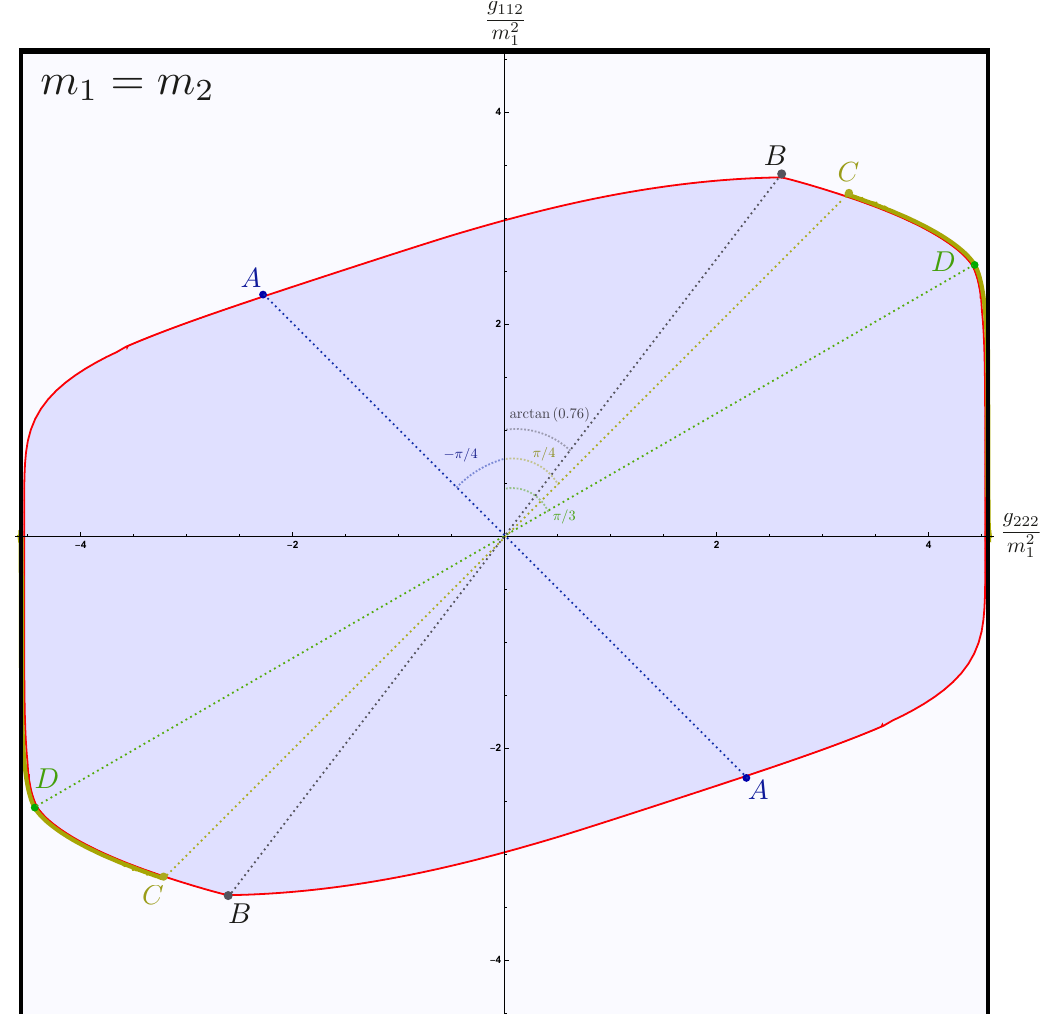
Figure 9. Allowed space of couplings for equal masses. A: potts massive (cid:12)eld theory, B: maximum coupling g 112 , C : beginning of elliptic deformation line, D : supersymmetric sine-Gordon (along the elliptic deformation